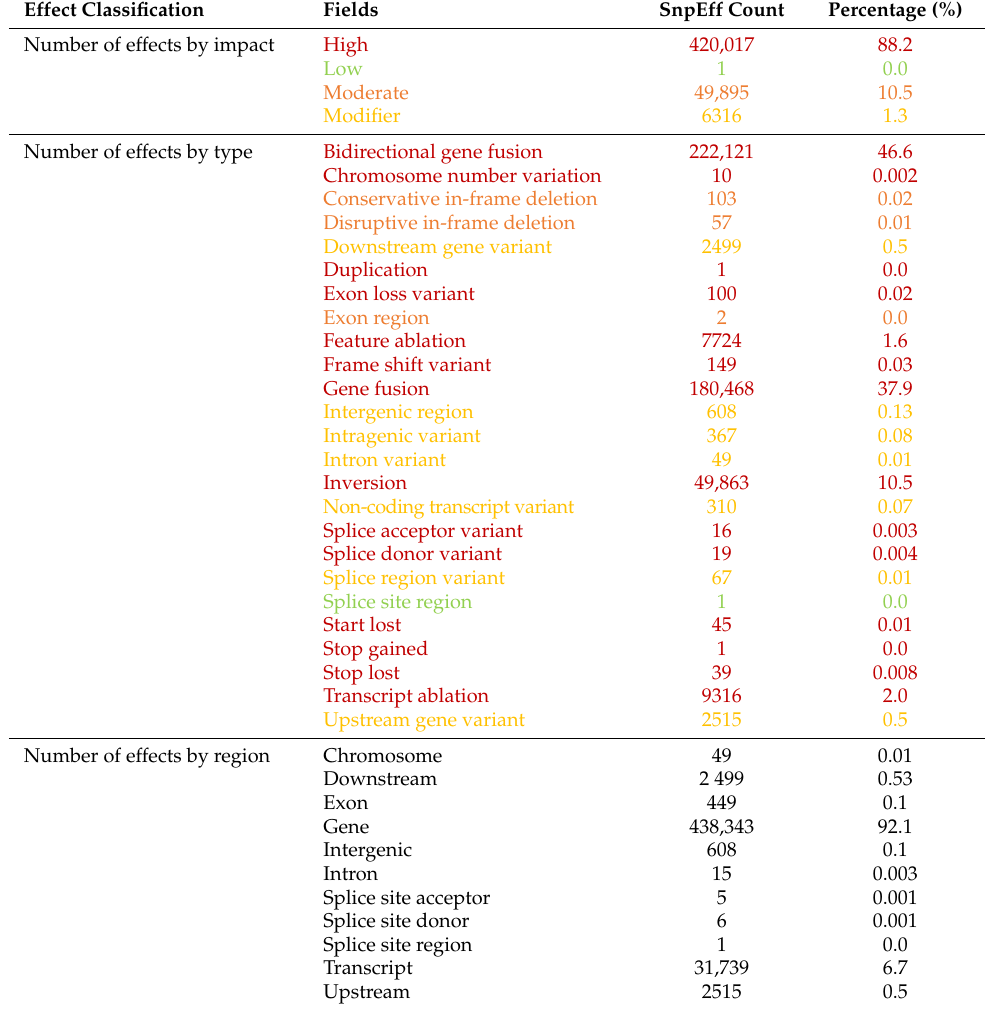
Table 5. SnpEff annotation summary for macro structural variants (SVs) indicating number of effects. The impact of the different types of effects are indicated in differing colours: High impact (red), moderate impact (orange), low impact (green) and modifier effect